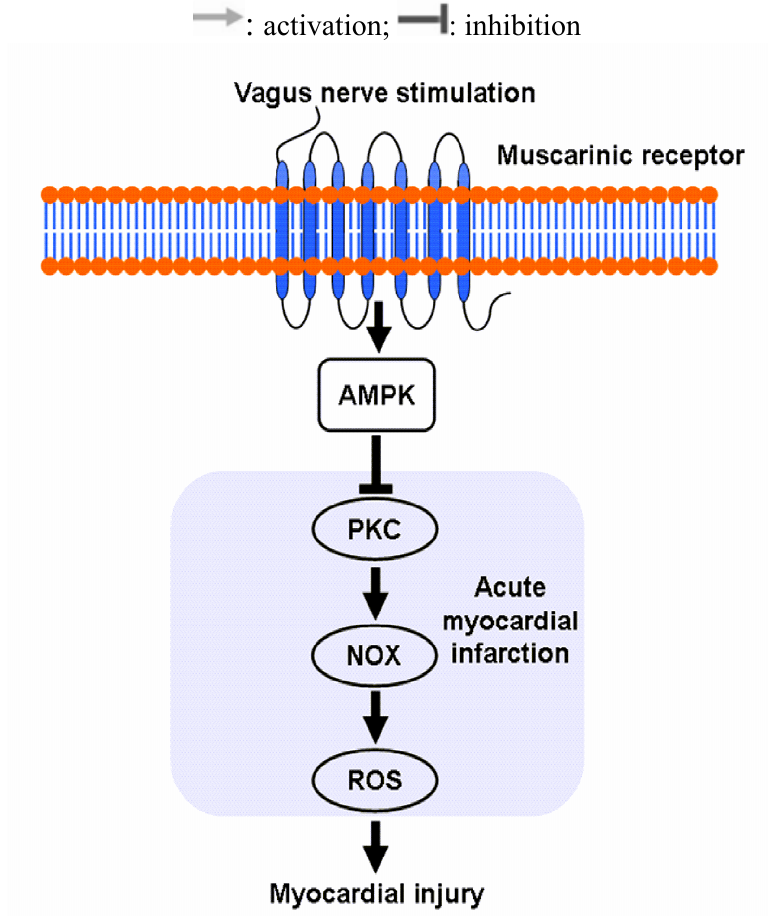
Figure 8. Schematic overview of the protective effects of the VNS on myocardial ischemia-induced ROS production. VNS can inhibit the myocardial ischemia induced-ROS production mainly through the AMPK-PKC-Nox pathway and muscarinic receptor is involved in the cardioprotection role of